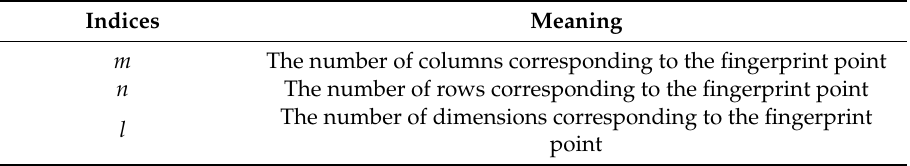
Figure 1. Fingerprint positioning based on visible light communication (VLC): ( a ) The positioning model; ( b ) The collection directions of fingeprints in x -axis, y -axis and z -axis. Table 1. The meaning of the indices.